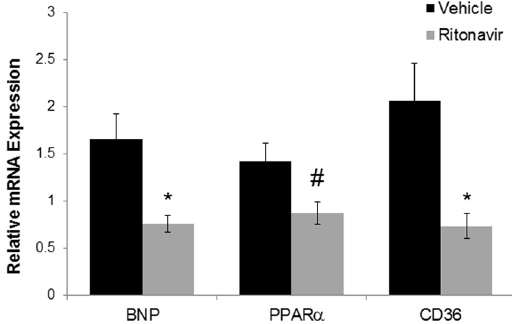
Figure 2. Effects of Chronic Ritonavir Treatment on BNP, PPAR α and CD36 Expression by Left Ventricle. The relative mRNA expression of BNP, PPAR α , and CD36 in LV of 75 day old male TG9 mice, treated with vehicle or ritonavir since 6 weeks of age, was examined by RT-PCR as described in Methods. (n = 4–5/group). * p < 0.01 vs. Veh, # p < 0.05 vs. Veh.